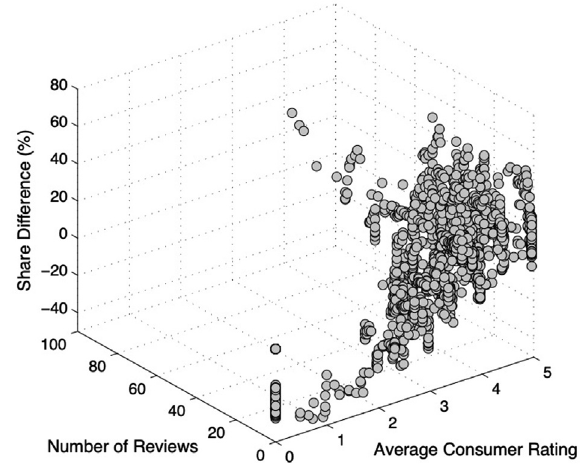
Fig. 4. 3D scatter plot of market share difference (%) with and without consumer reviews across products and